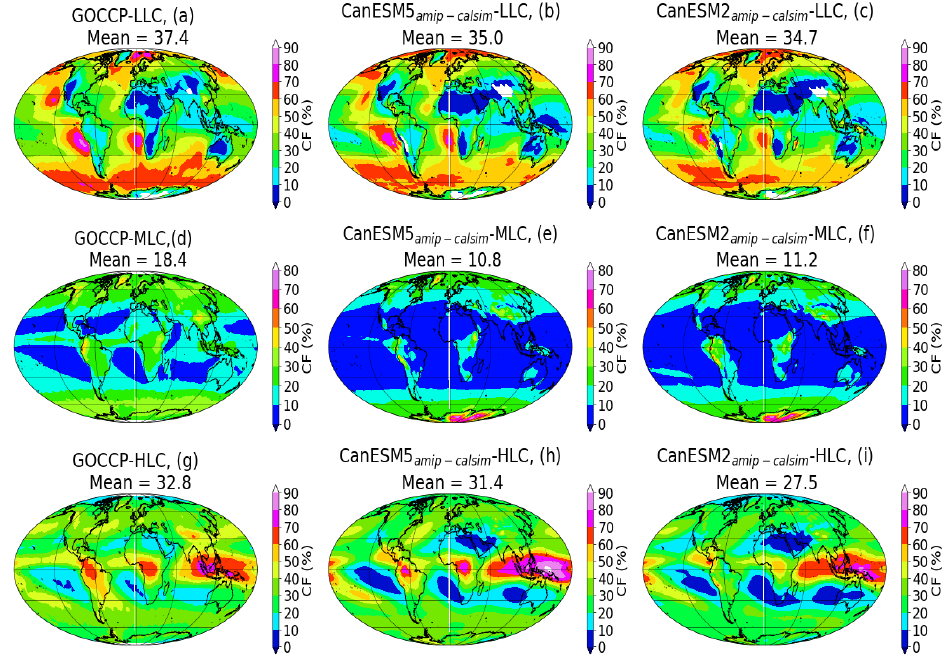
Figure 4. Annually averaged global distribution of cloud fraction (CF) of low-level clouds (LLC), mid-level clouds (MLC), and high-level clouds (HLC) based on GOCCP and CanESM models.